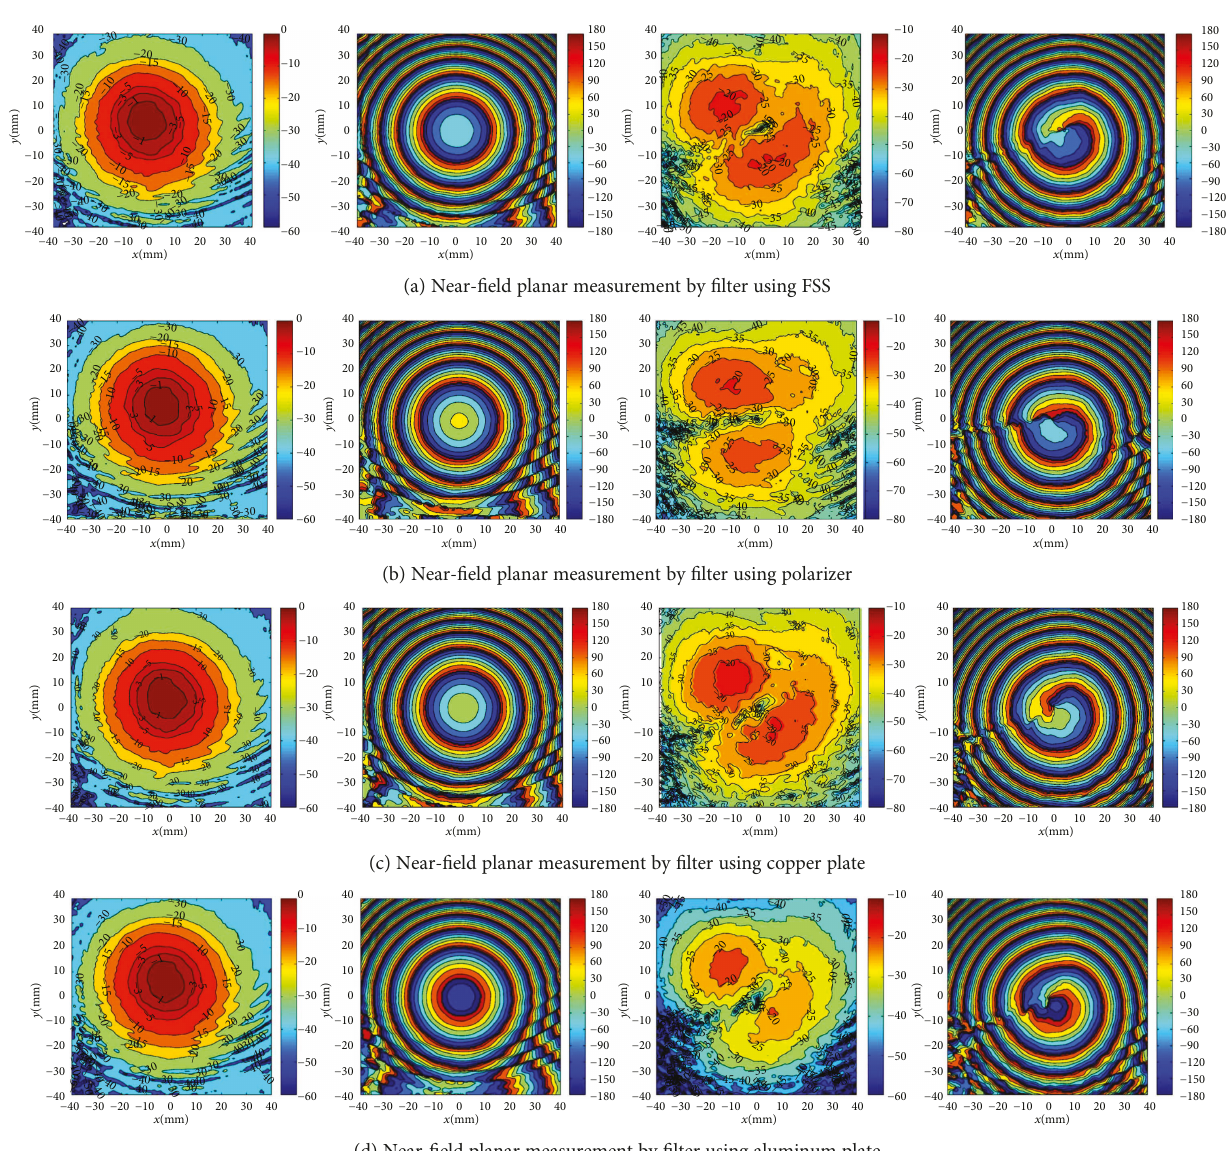
(d) Near- fi eld planar measurement by fi lter using aluminum plate Figure 9: The near- fi eld measurement results of 183GHz channel in the dual-channel 3D QON system. From left to right are the measured plane of copolarization amplitude, the copolarization phase, the cross-polarization amplitude, and the cross-polarization phase. Table 1: The near- fi eld measurement data of 183 GHz